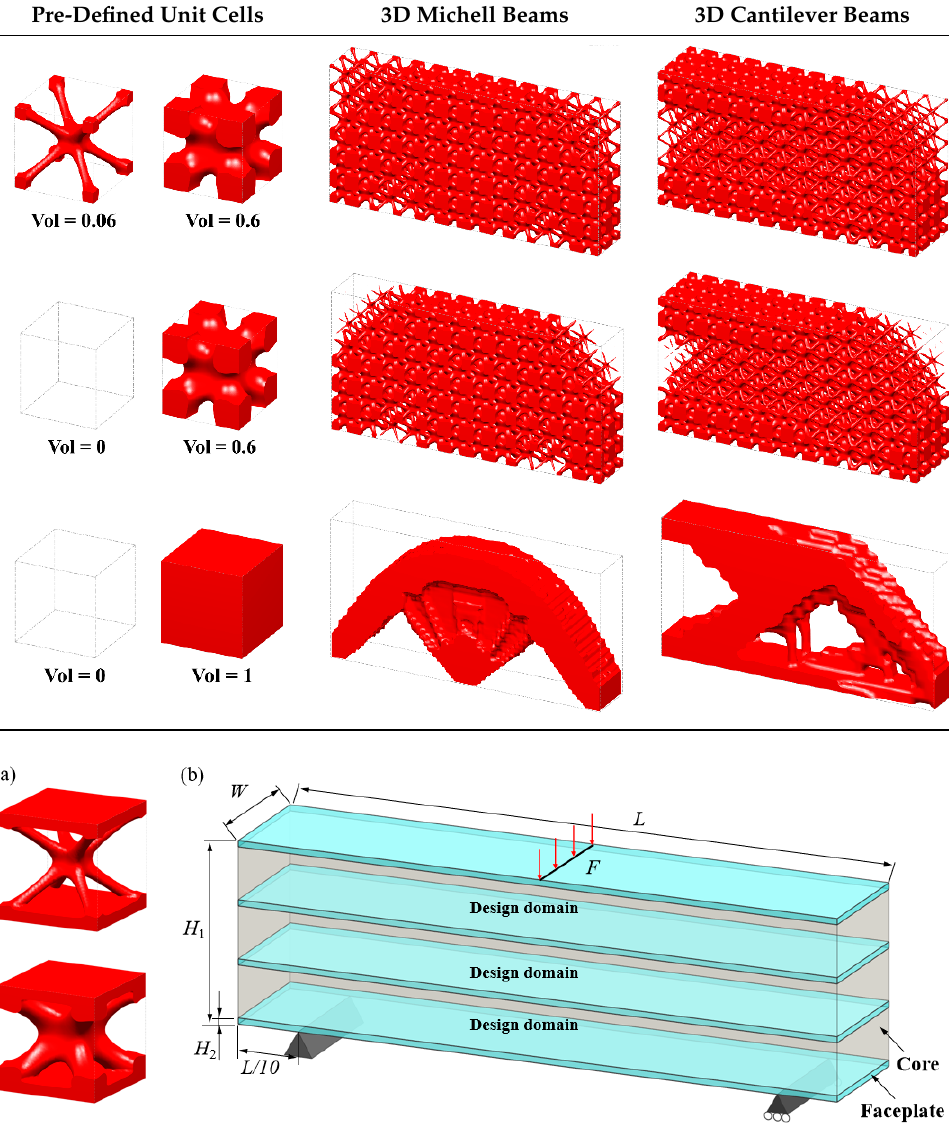
Figure 17. Pre-defined unit cells and design domain of LSS. ( a ) LSS unit cells with different volume fractions. ( b ) Loading and boundary conditions for 3D LSS.